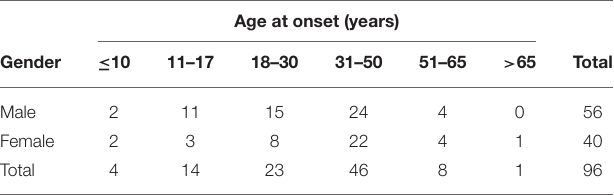
TABLE 1 | Age and sex distribution of 96 patients with LPG in